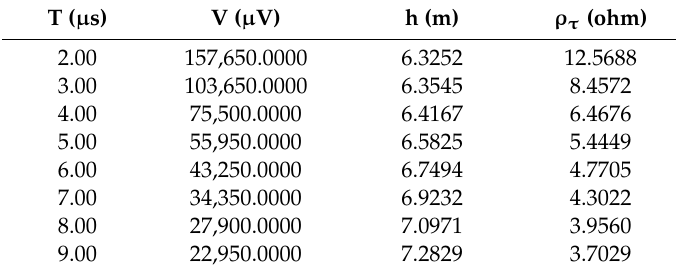
Table 2. Results of application the S-transformation to the experimental